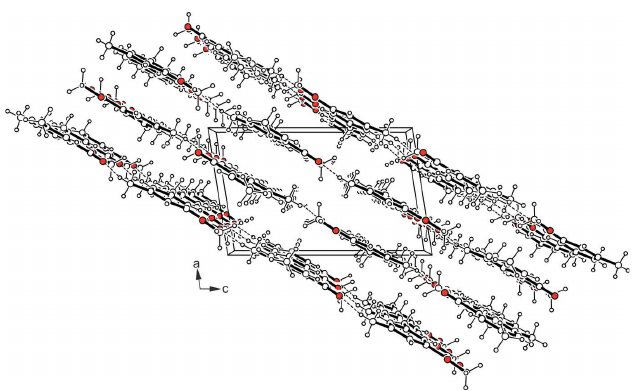
Figure 4 Packing diagram of 1 viewed down the crystallographic b -axis.